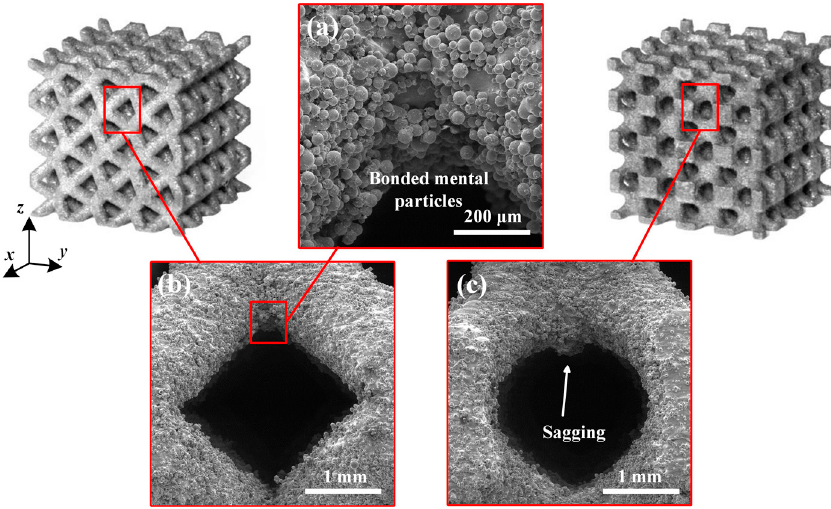
Figure 5. SEM micrographs of ( a , b ) CAD-based and ( c ) TPMS-based BCC lattice